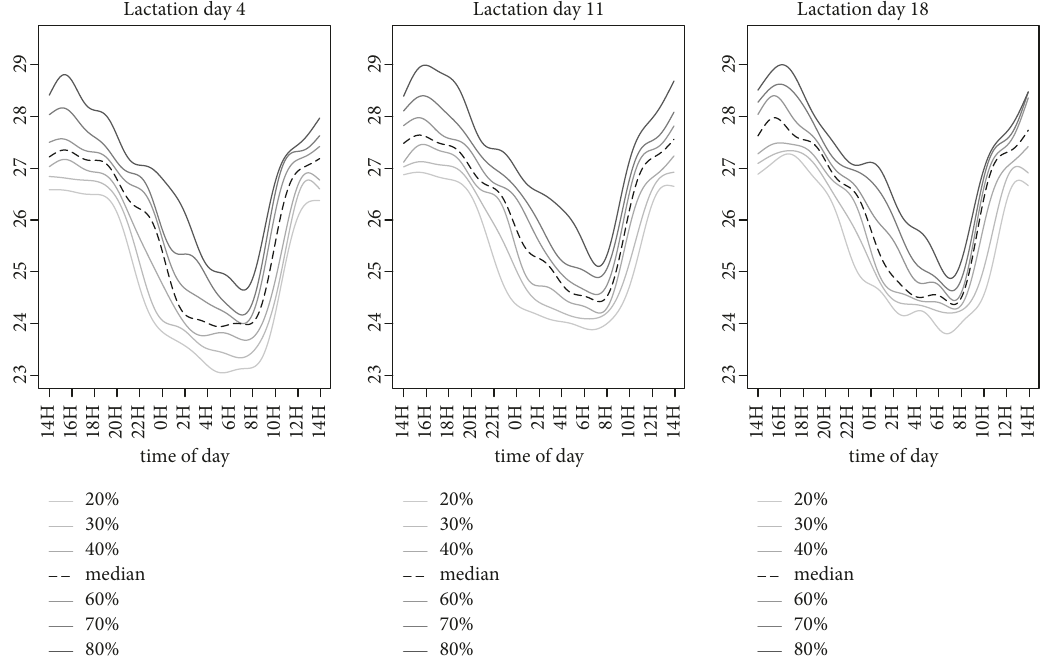
Figure 2: Temperature curves with which prediction of quantiles is made. Dashed black line is pointwise average of temperature curves and solid lines are pointwise quartiles; all curves are